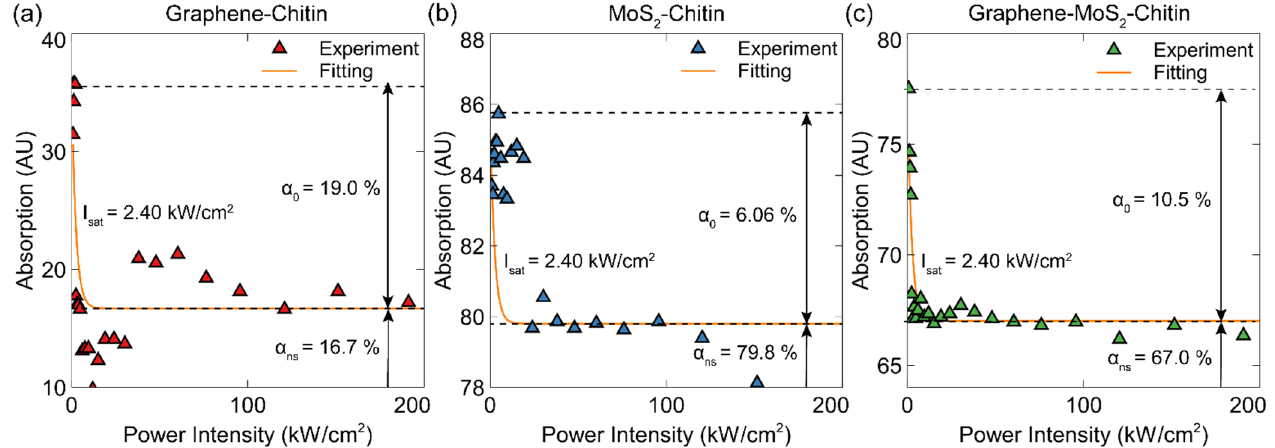
Figure 9. Non-linear absorption of ( a ) graphene-chitin, ( b ) MoS 2 -chitin and ( c ) graphene-MoS 2 -chitin.